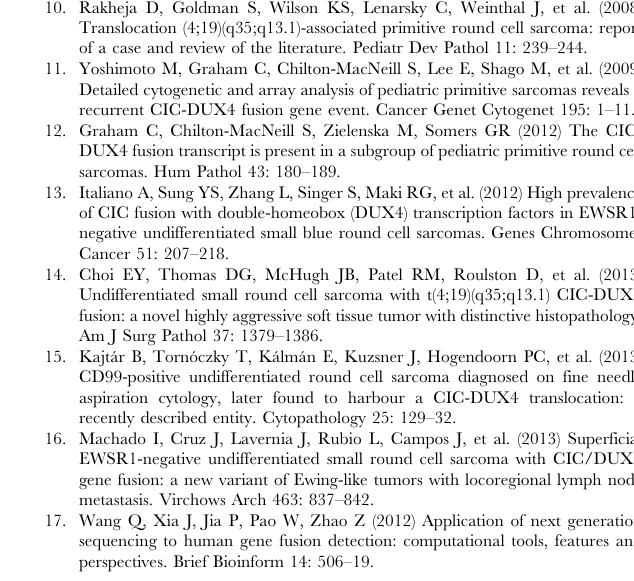
Table S1 Fusion transcripts detected using FusionMap. Table S2 Fusion transcripts detected using FusionFinder. Table S3 Fusion transcripts detected using